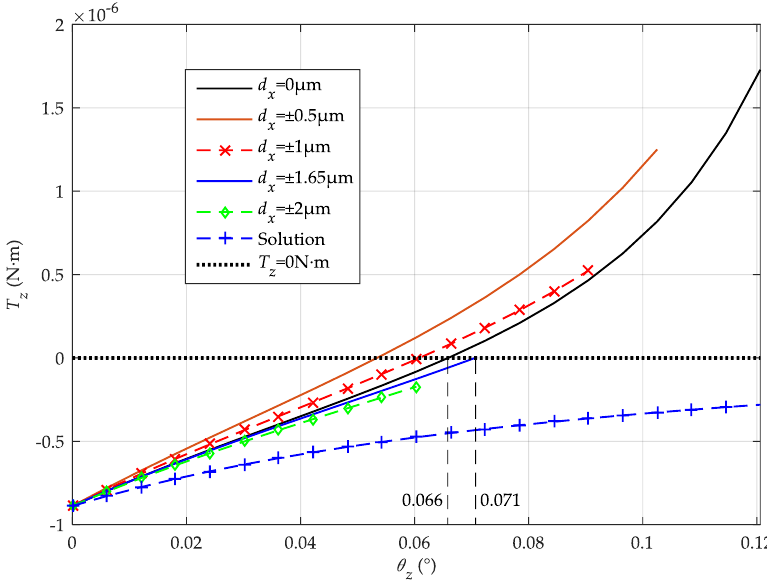
Figure 5. Electrostatic torque vs. initial rotation angle around the z -axis in different situations.